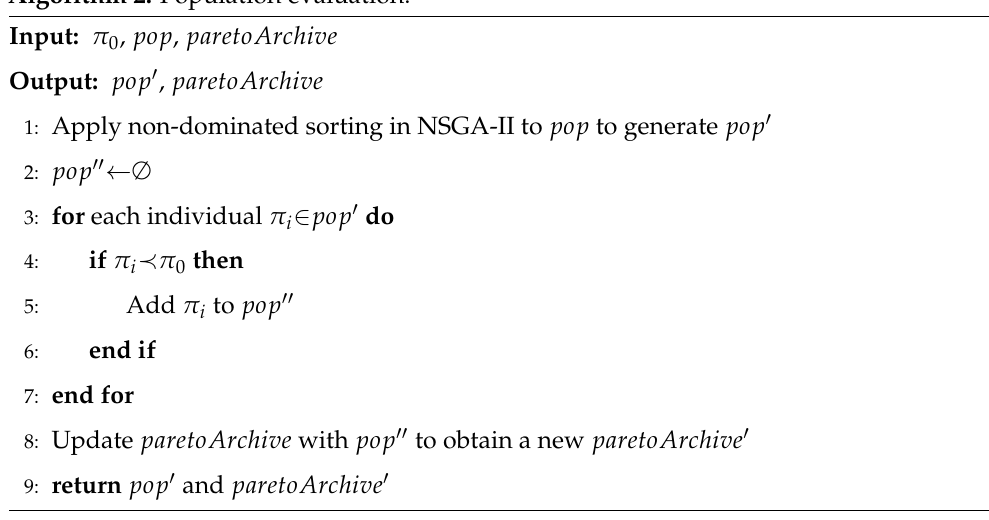
Algorithm 2. Population evaluation.